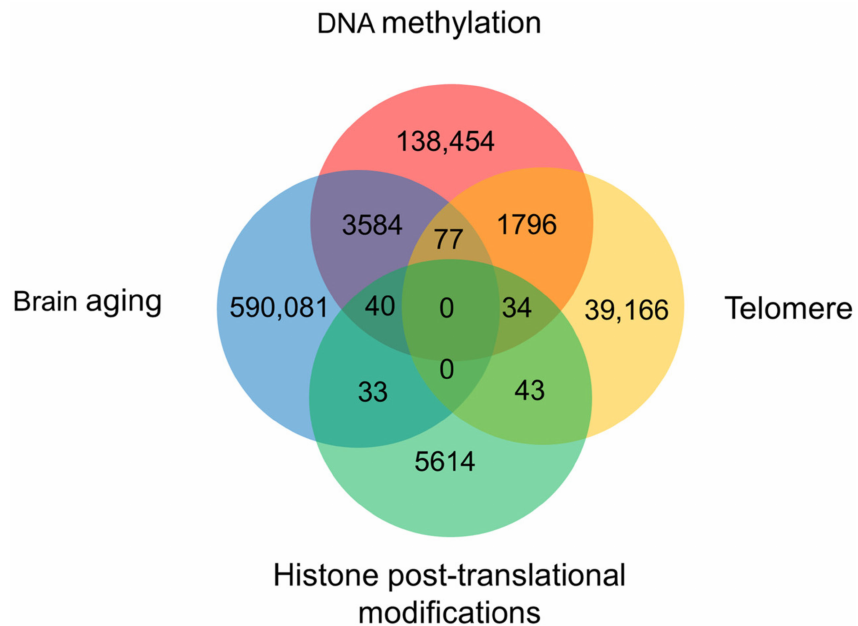
Figure 3. The weight of DNA methylation, histone modifications, and telomere in the process of brain aging. A Venn diagram created by summarizing publications in the Web of Science Core Collection, Chinese Science Citation Database, KCI-Korean Journal Database, MEDLINE, and SciELO Citation Index since